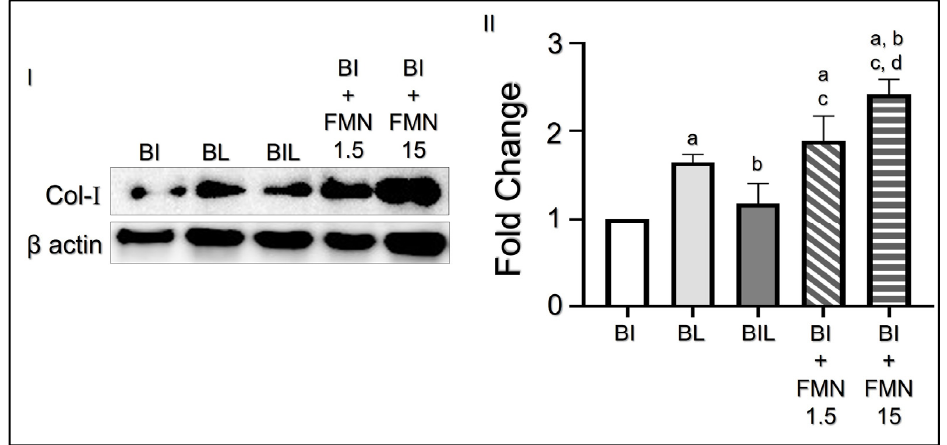
Figure 5. Col-I expressions of the cecum after different treatments. ( I ) Western blot images of Col-I and β -actin of each mouse cecum after treatment with L. plantarum MA in the presence of roseoflavin (BI), lactulose (BL), roseoflavin + lactulose (BIL), roseoflavin + 1.5 µ M FMN (BI + FMN 1.5), or roseoflavin + 15 µ M FMN (BI + FMN 15) for 24 h. ( II ) Quantitative analyses of the Col-I expressions shown in ( I ). Values are the mean ± SD (n = 3). a, b, c, and d represent p < 0.05 compared to the groups treated with BI, BL, BIL, and BI + FMN 1.5,